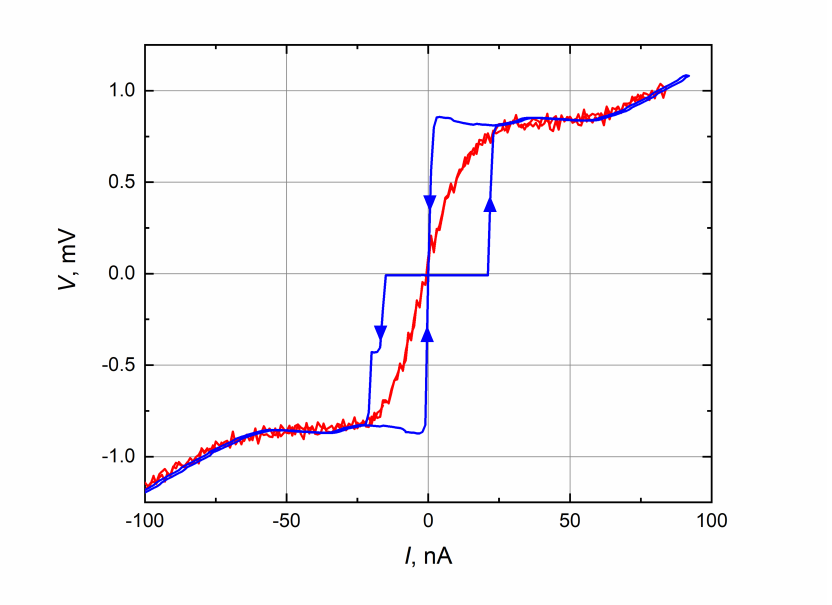
Figure A3. The IVC recorded for a two-unit SQUID device with different measurement setups at T = 25 mK (sample 3 in Table 1). Without thorough filtering, the IVC was non-hysteretic and smeared. Proper filtering of all leads enables observation of a well-developed hysteresis expected for an underdamped junction at low T